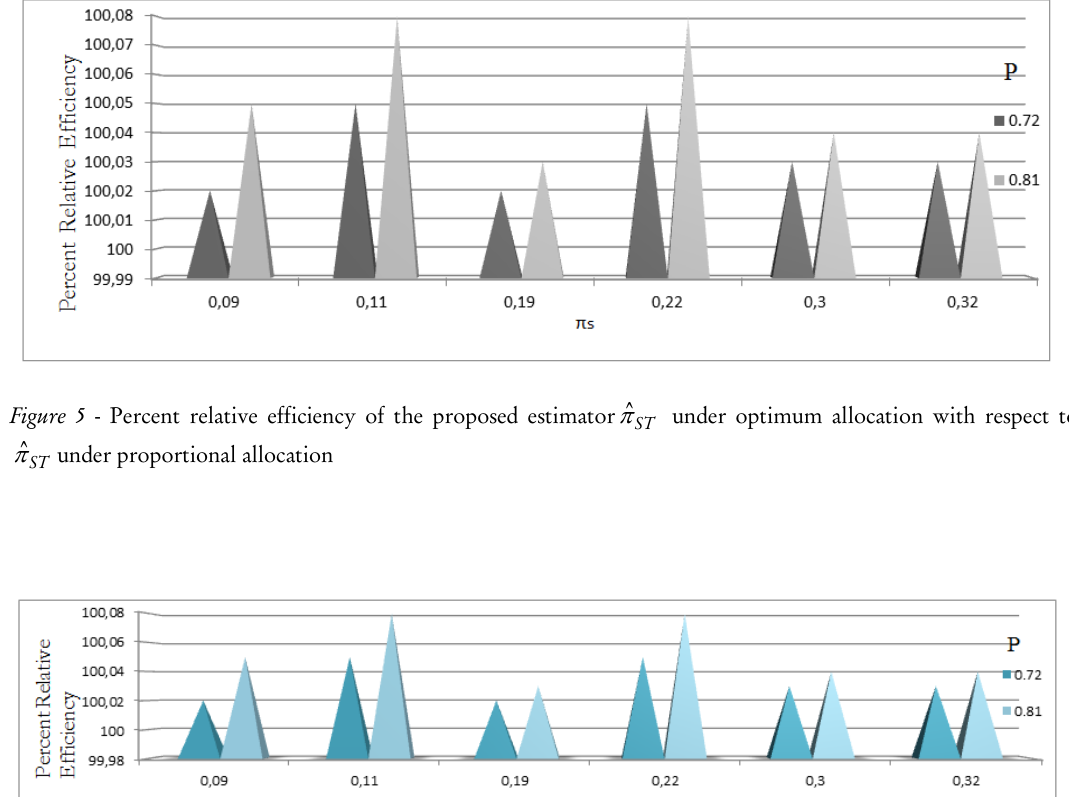
Figure 3 - Percent relative efficiency of the proposed estimator Mangat and Singh (1994) estimator